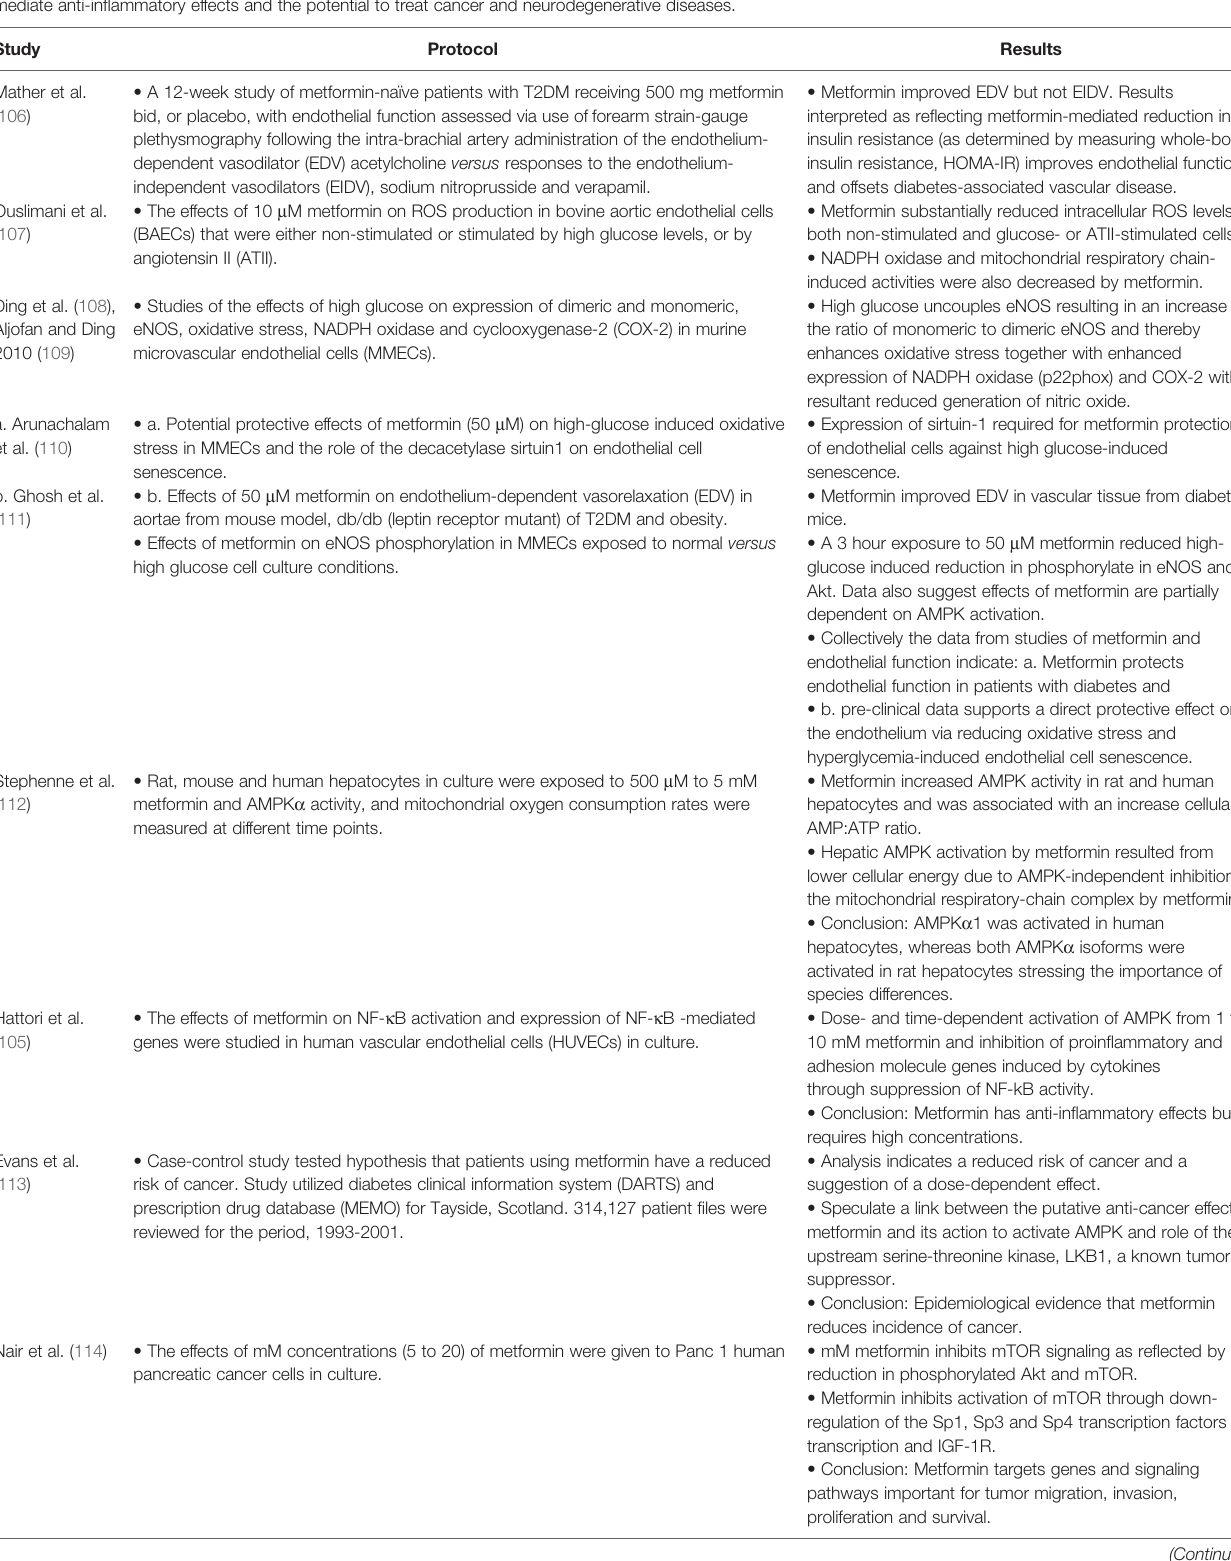
TABLE 2 | Summaries of studies that focus on cellular actions of metformin to activate AMPK, reduce generation of reactive oxygen species, improve vascular function, mediate anti-in fl ammatory effects and the potential to treat cancer and neurodegenerative